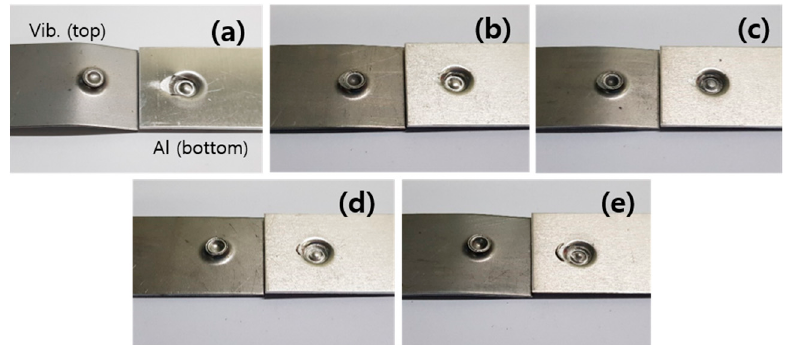
Figure 9. Failure modes for SPR joint of vibration-damping steel (top) and Al5052-H32 (bottom) with respect to SPR die type. ( a ) Type A1 die, ( b ) type A2 die, ( c ) type A3 die, ( d ) type B die, and ( e ) type C die.